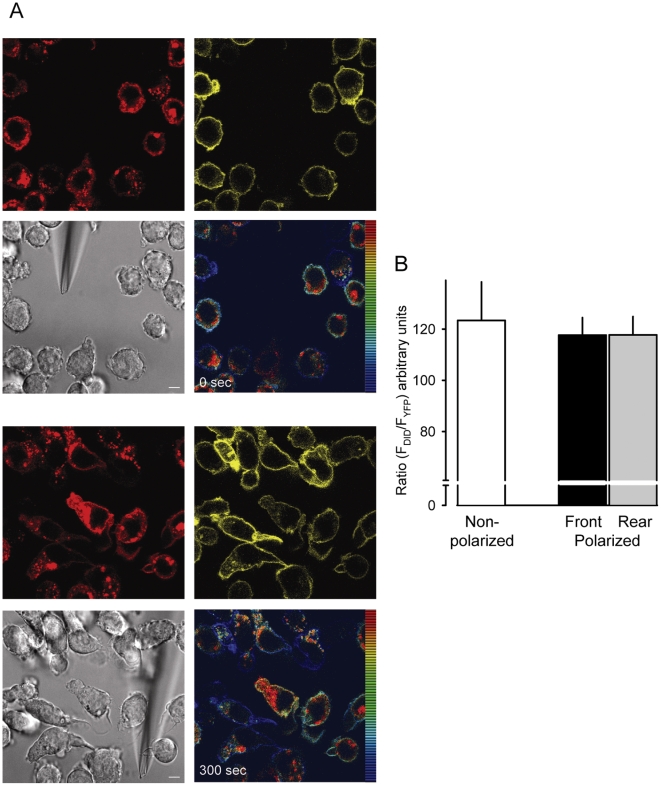
Receptor localization in resting and polarized cells.(A) Selected frames from Movies S2 just after insertion of the micropipette dispensing 300 nM UK 14'304 (0 sec, upper images) and after 5 min (300 sec, lower images). Red fluorescence derives from the membrane marker DiD (594 nm excitation/620–680 nm emission), yellow fluorescence derives from the YFP tag of α2AAR CFP/YFP (514 nm excitation/525–590 nm emission). Both fluorescences were recorded contemporaneously. The false color shows the ratio of red/yellow. Gray, corresponding phase image. The bar in the phase images represents 5 µm. (B) Average ratio-intensity analysis of regions of interest (ROI) measured in resting cells (white bar, non polarized) and polarized cells stimulated with 300 nM UK 14'304 at the front (black) or rear (grey). Data represent the mean values from multiple frames from 3 different cells each from 3 independent experiments. The threshold for data inclusion was set equal in all experiments.